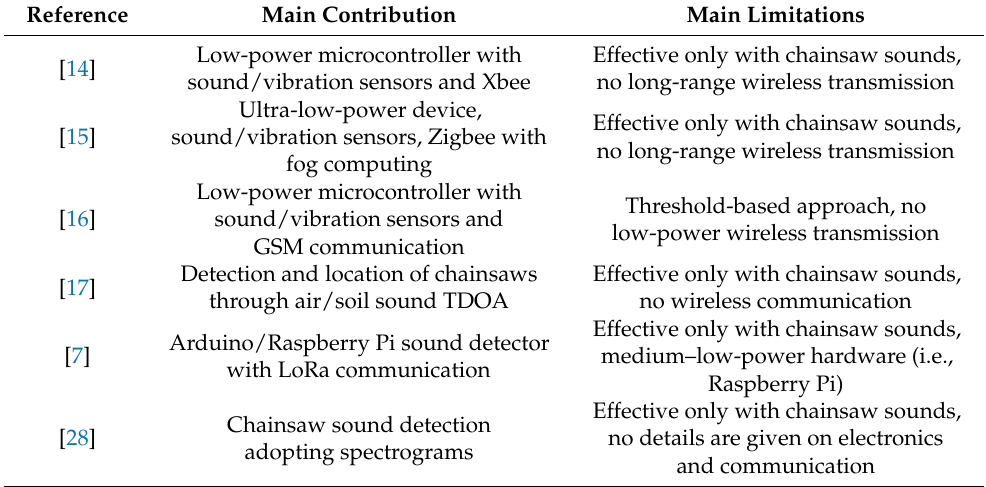
Table 1. Overview on tree-cutting detection contributions in the literature and respective